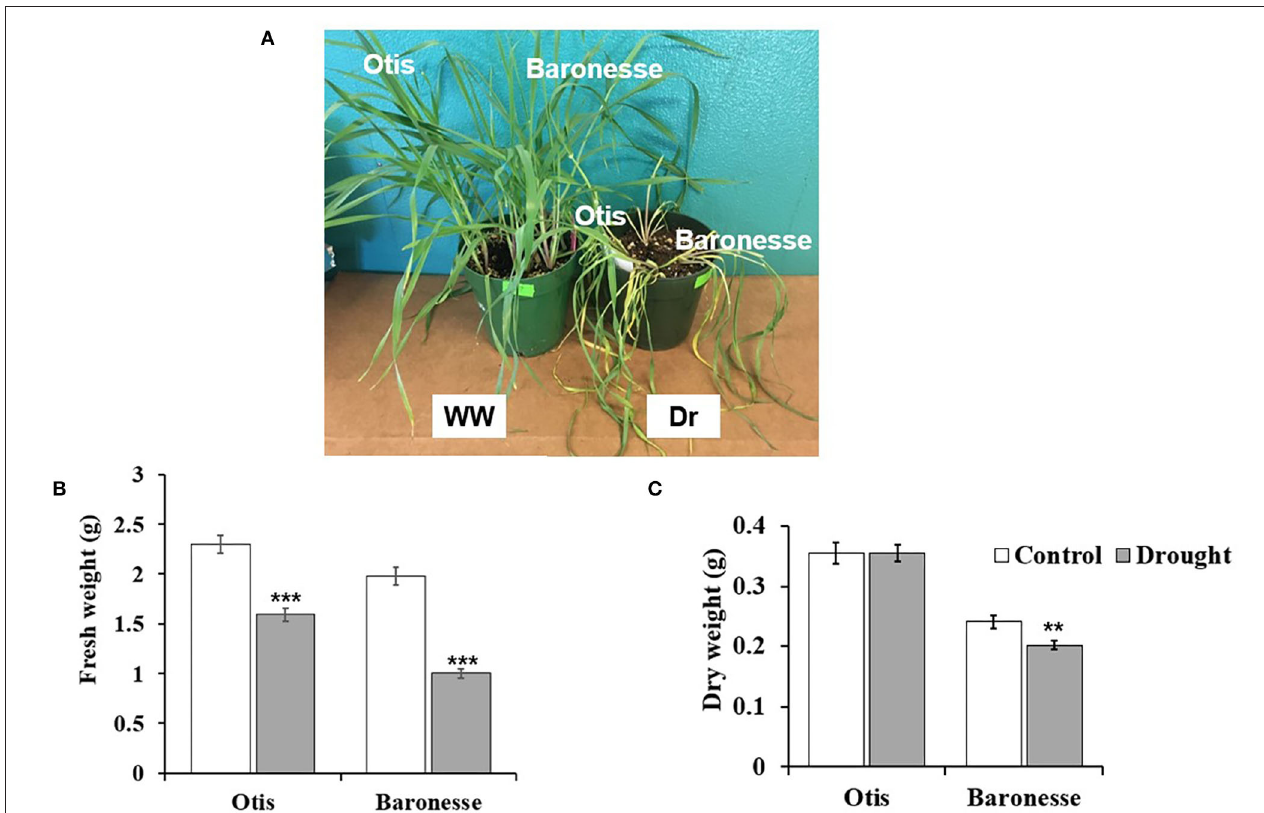
FIGURE 1 | Morphological changes between Otis and Baronesse under drought stress. (A) Barley plants of Otis and Baronesse under well-watered (WW) and drought (Dr) conditions. (B) Fresh weight (FW) of the main shoot (g). (C) Dry weight (DW) of the main shoot (g). Bars represent standard errors of the means. N = 10 plants. ** P < 0.01 and *** P <